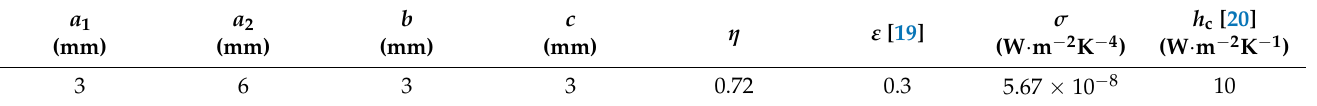
Figure 5. Assessment of the heat source. Table 6. Heat source and material property